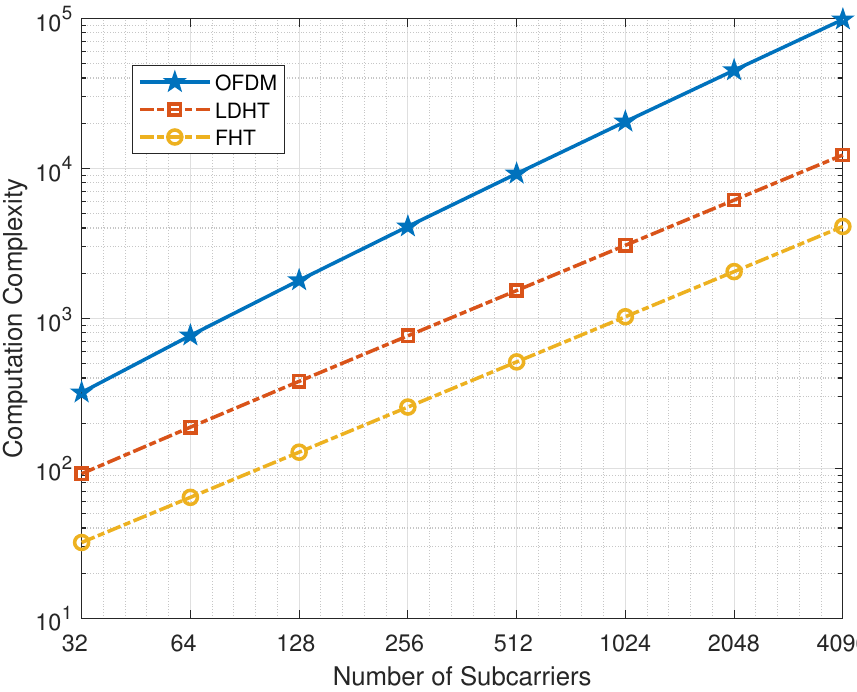
Figure 3. Transmitter-side performance comparisons of complexities of the proposed fast DHT-IDFT and other schemes.